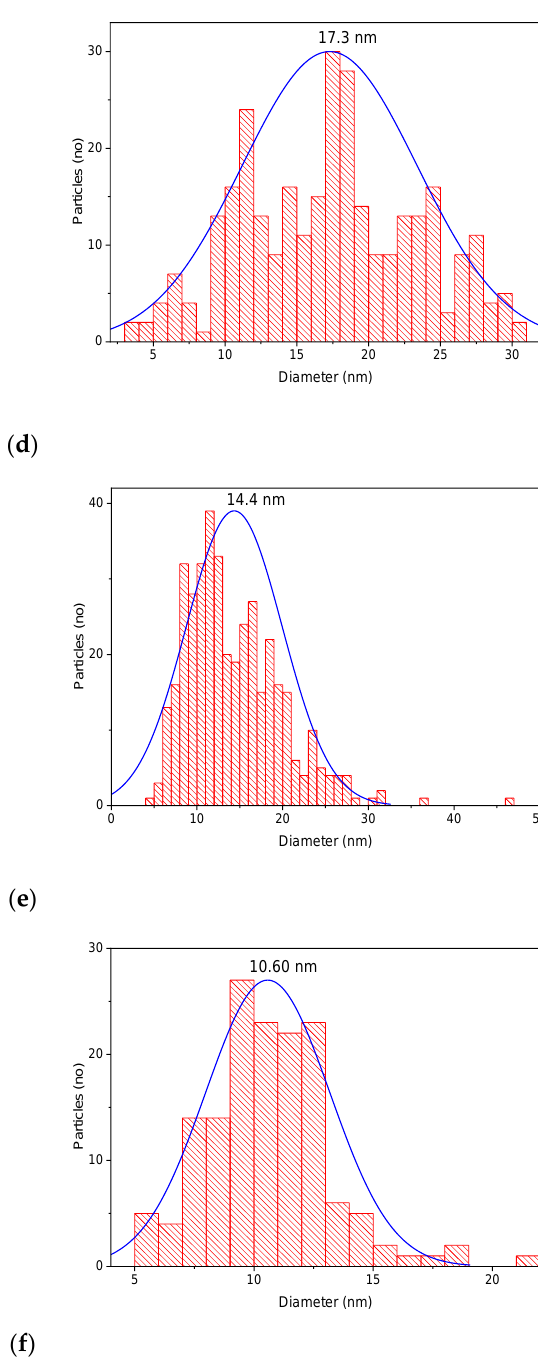
Figure 6. TEM images and size distributions obtained for the phytosynthesized nanoparticles: ( a ) sample EE5; ( b ) sample EE2; ( c ) sample EE1; ( d ) sample EM5; ( e ) sample EM2; ( f ) sample EM1.